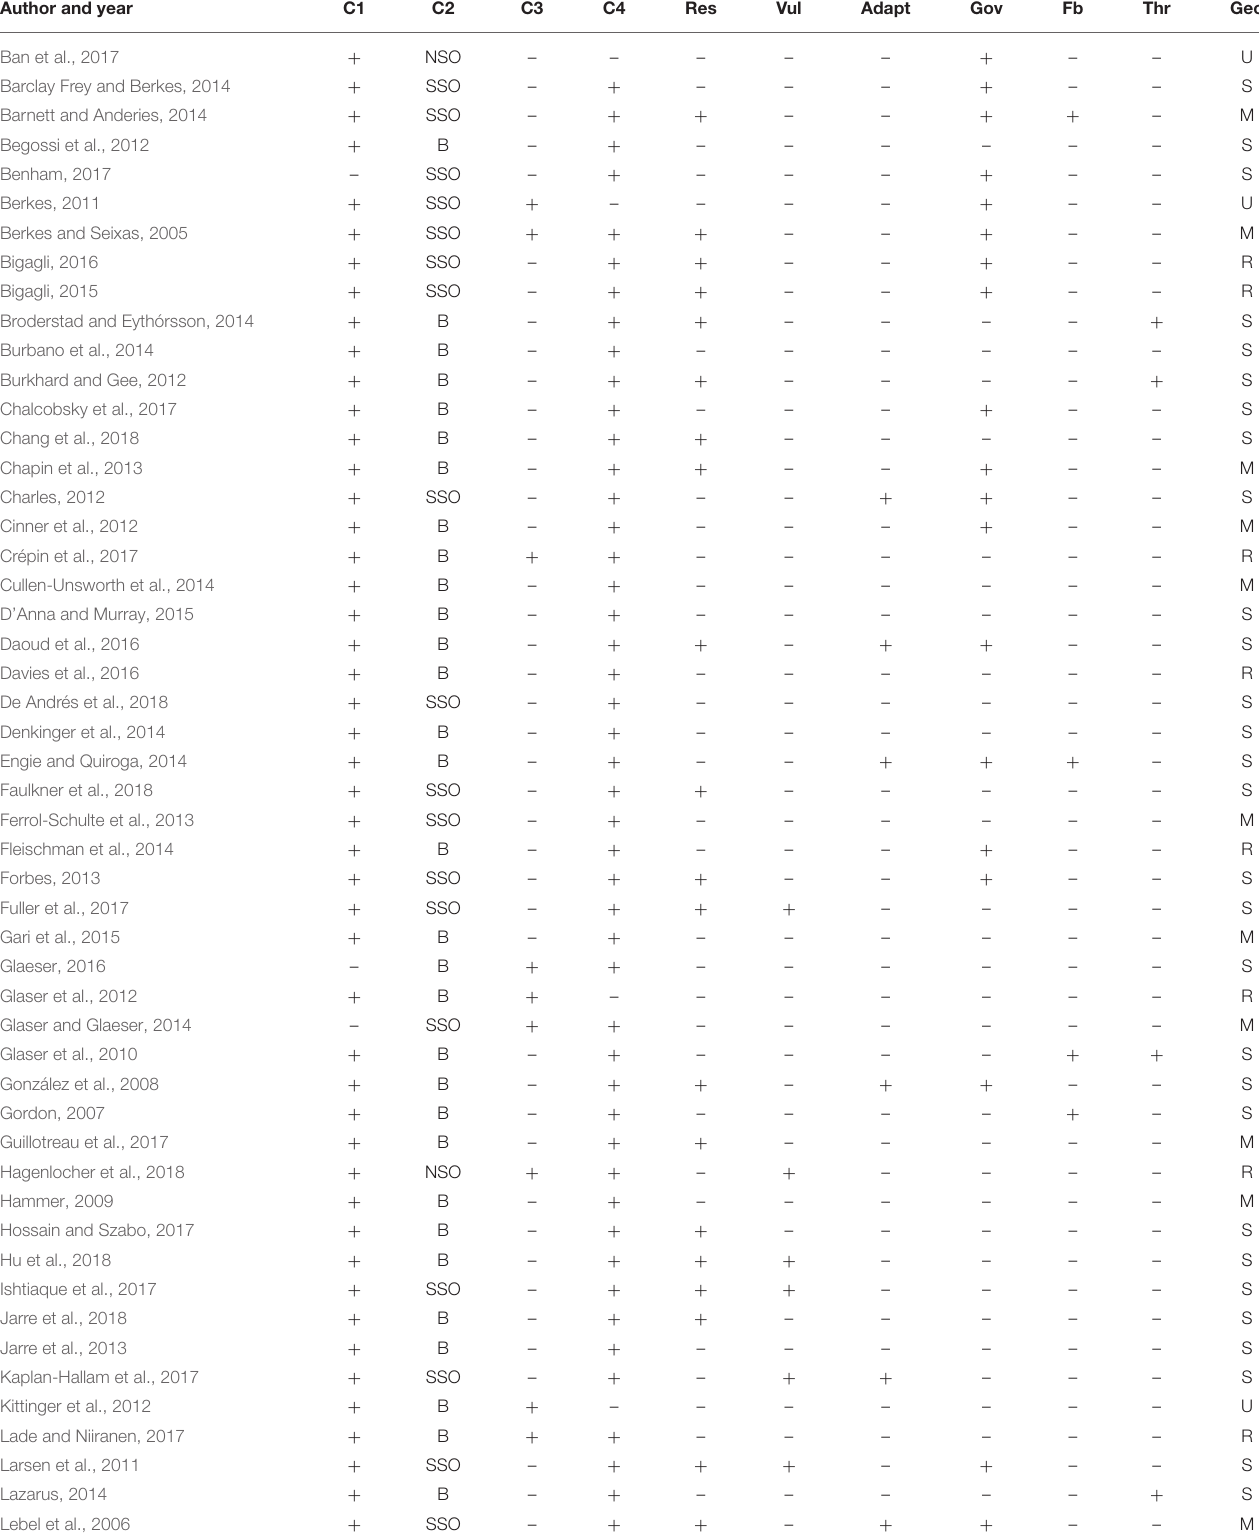
TABLE 1 | Description of the literature sample on coastal and marine SESs ( n =